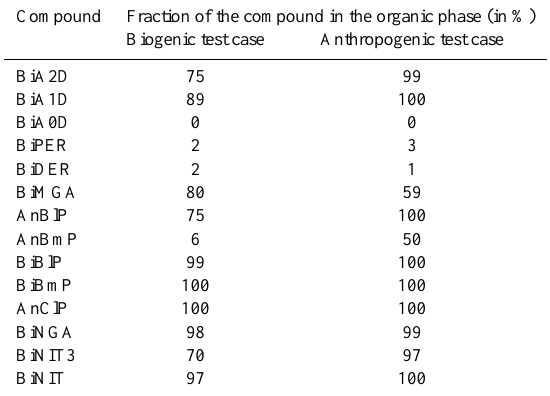
Table 8. Distributions of surrogate organic compounds between the aqueous phase and the organic